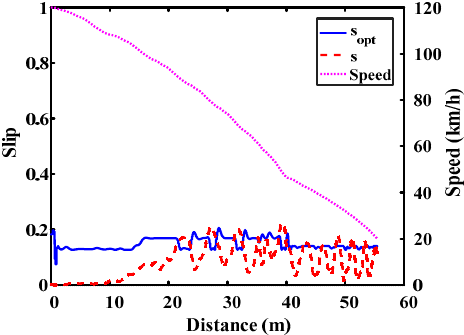
Figure 16. Optimum slip, real slip and speed.